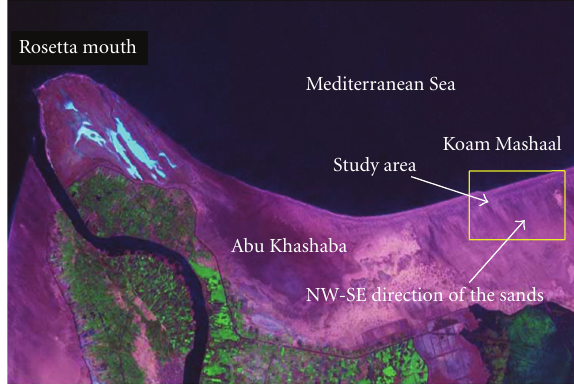
Figure 11: Northern Egypt Landsat colour composite image showing the location of the studied Koam Mashaal beach area, East Rosetta, Mediterranean Sea